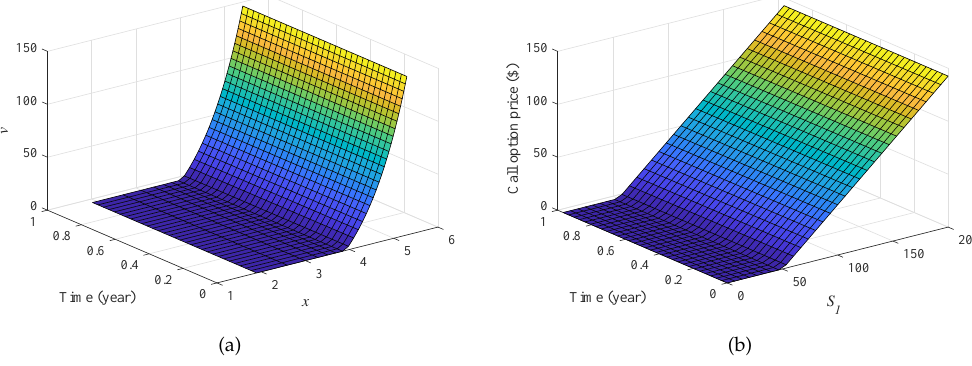
Figure 2. ( a ) Transformed explicit solution, v , and ( b ) call option price, c , for all time of order α = 0.9 with S 2 = 10.